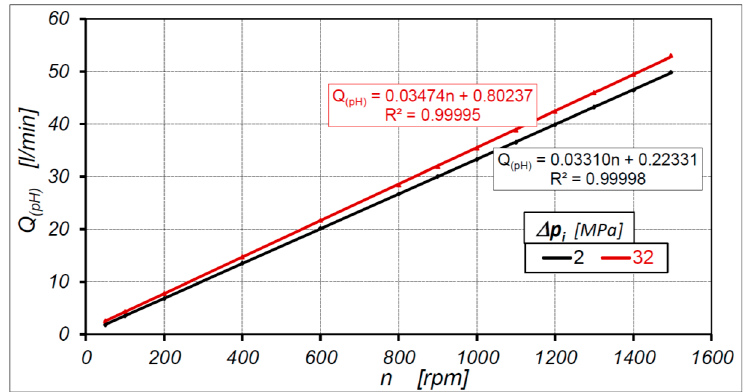
Figure 14. Characteristics of motor output flow rate Q ( pH ) related to the pressure in the high-pressure working chamber vs. rotational speed n at Δ p i = const.